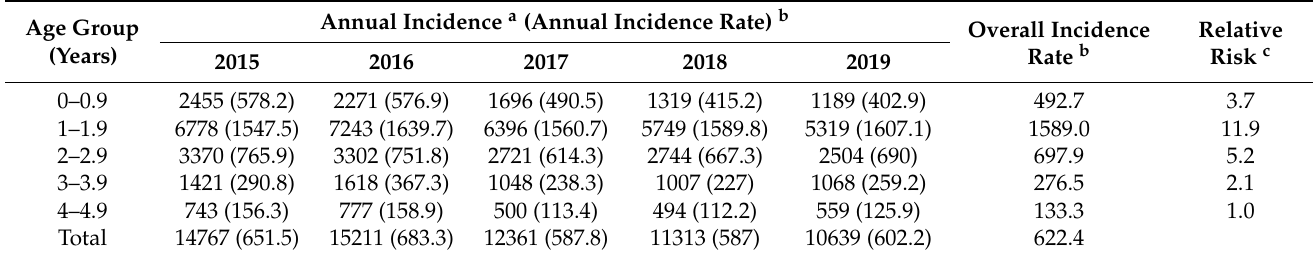
Table 3. The age-standardized incidence rate of febrile convulsion by age